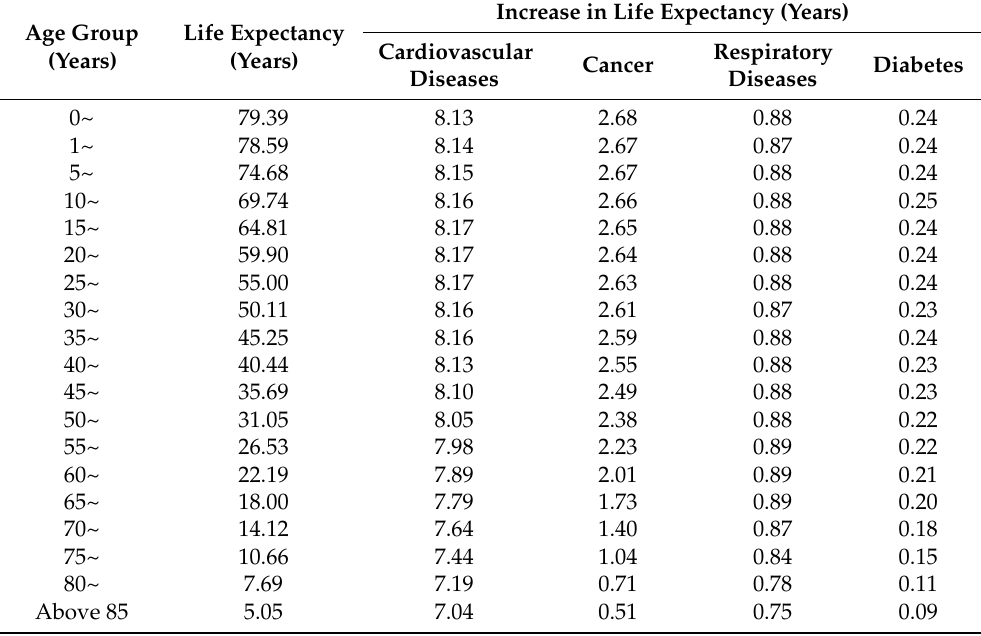
Table 1. Increases in life expectancy for different age groups after eliminating diseases’ deaths. China,